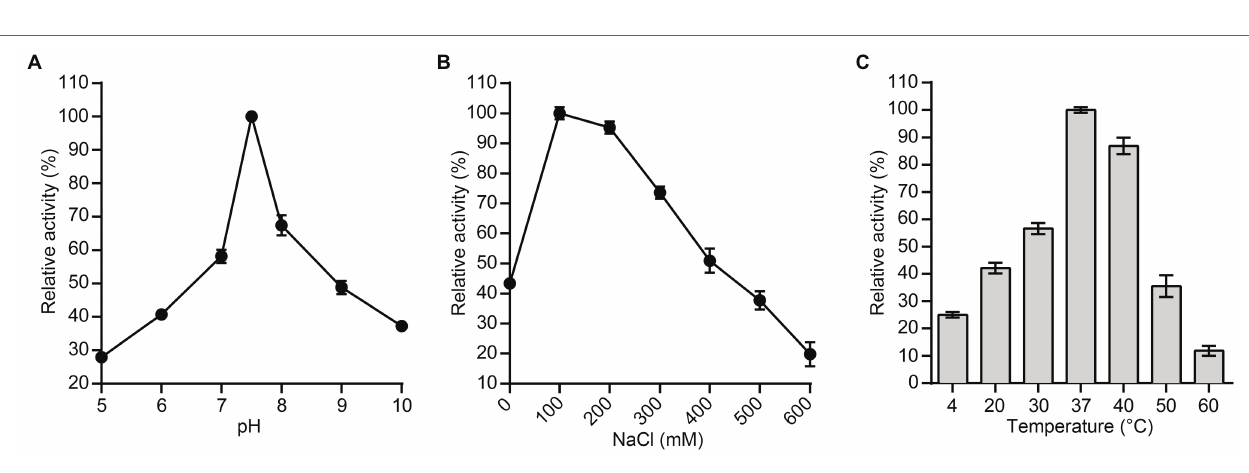
FIGURE 5 | Effects of different experimental conditions on lytic enzyme P9ly activity. (A) pH; (B) NaCl concentration; and (C) Temperature. Shigella dysenteriae KUST9, the host bacterium for bacteriophage PSD9, was used as an effector substrate for lytic enzyme P9ly. In addition, the maximum activity of P9ly under various test conditions was set as 100% to facilitate comparison. Every experiment was repeated in triplicate. The error bars represent the SD.